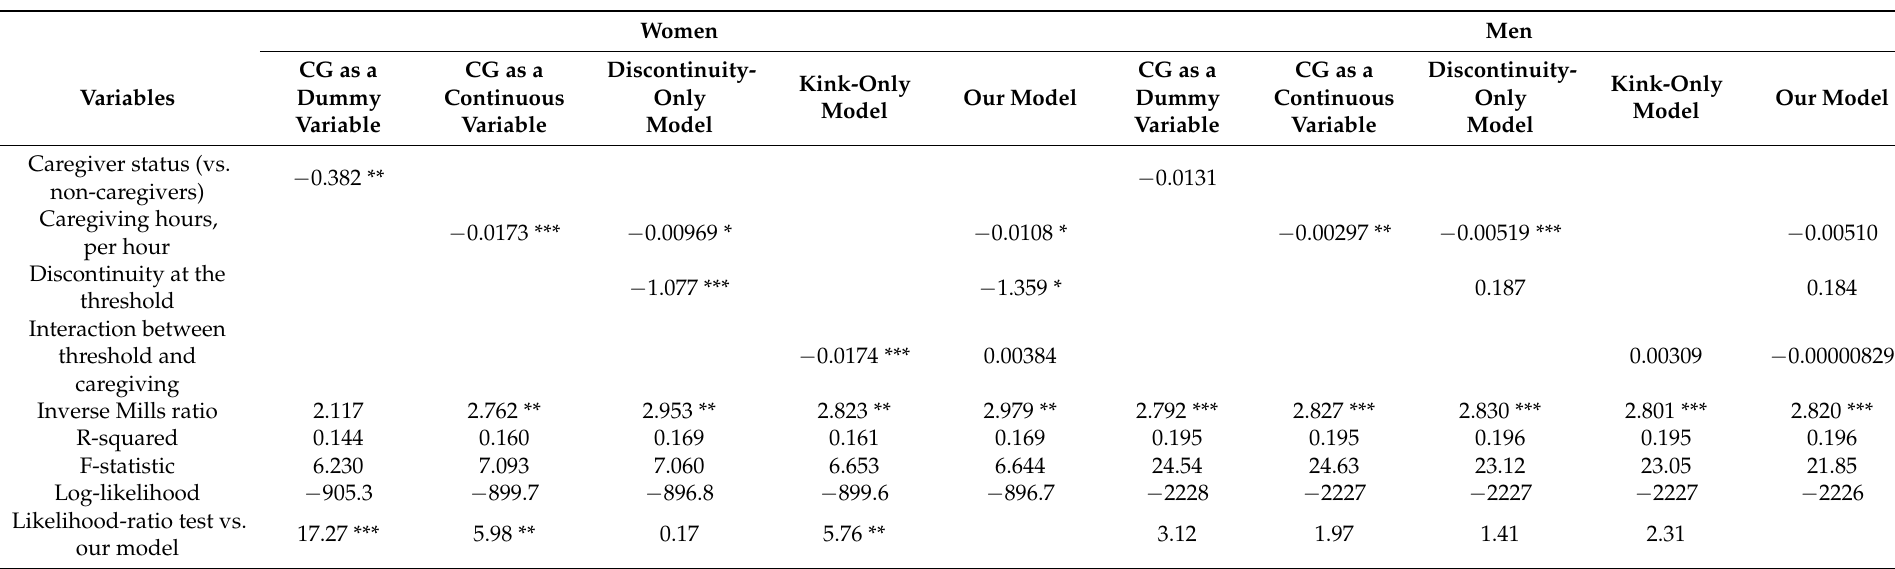
Table 5. Assessing the performance of the comprehensive model with four simpler models in predicting log-transformed monthly employment